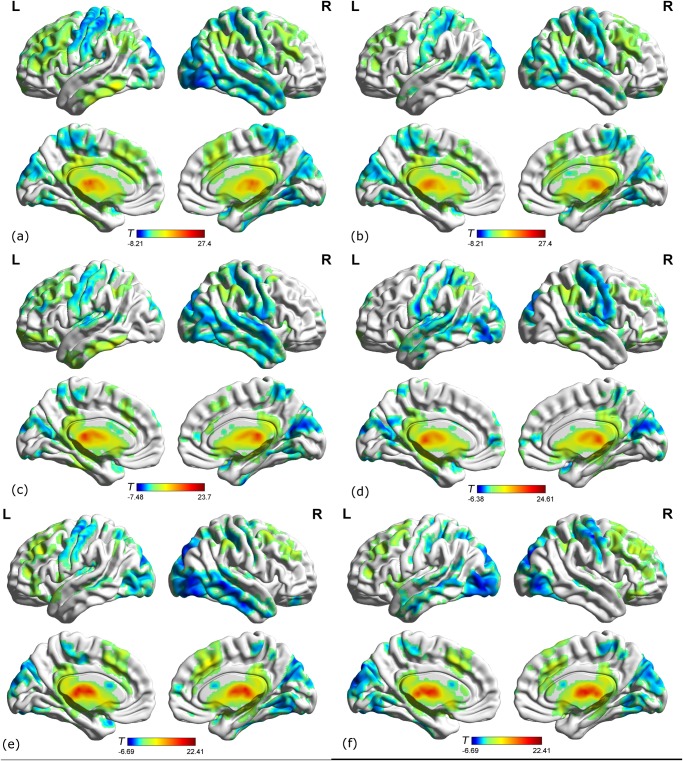
Brain regions show significant connectivity to the left/right thalamus in LMCI patients, EMCI patients and healthy age-matched control group (P < 0.01, 40 voxels, Alphasim corrected).(a) LMCI patients in the left thalamus; (b) LMCI patients in the right thalamus; (c) EMCI patients in the left thalamus; (d) EMCI patients in the right thalamus; (e) HC group in the left thalamus; (f) HC group in the right thalamus.